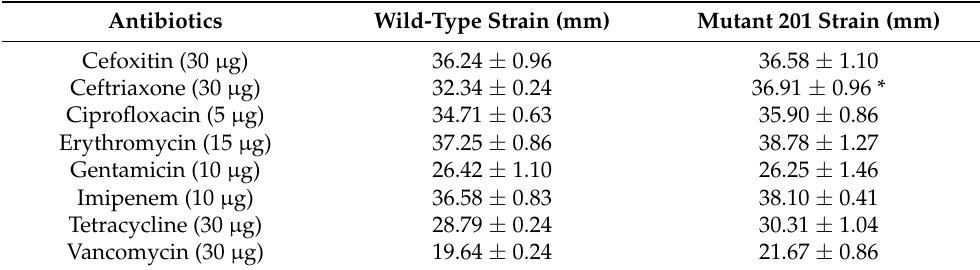
Table 5. Antibiotic susceptibility of Brevibacillus sp. SPR-20 and its mutant strain (means ± SD; n =